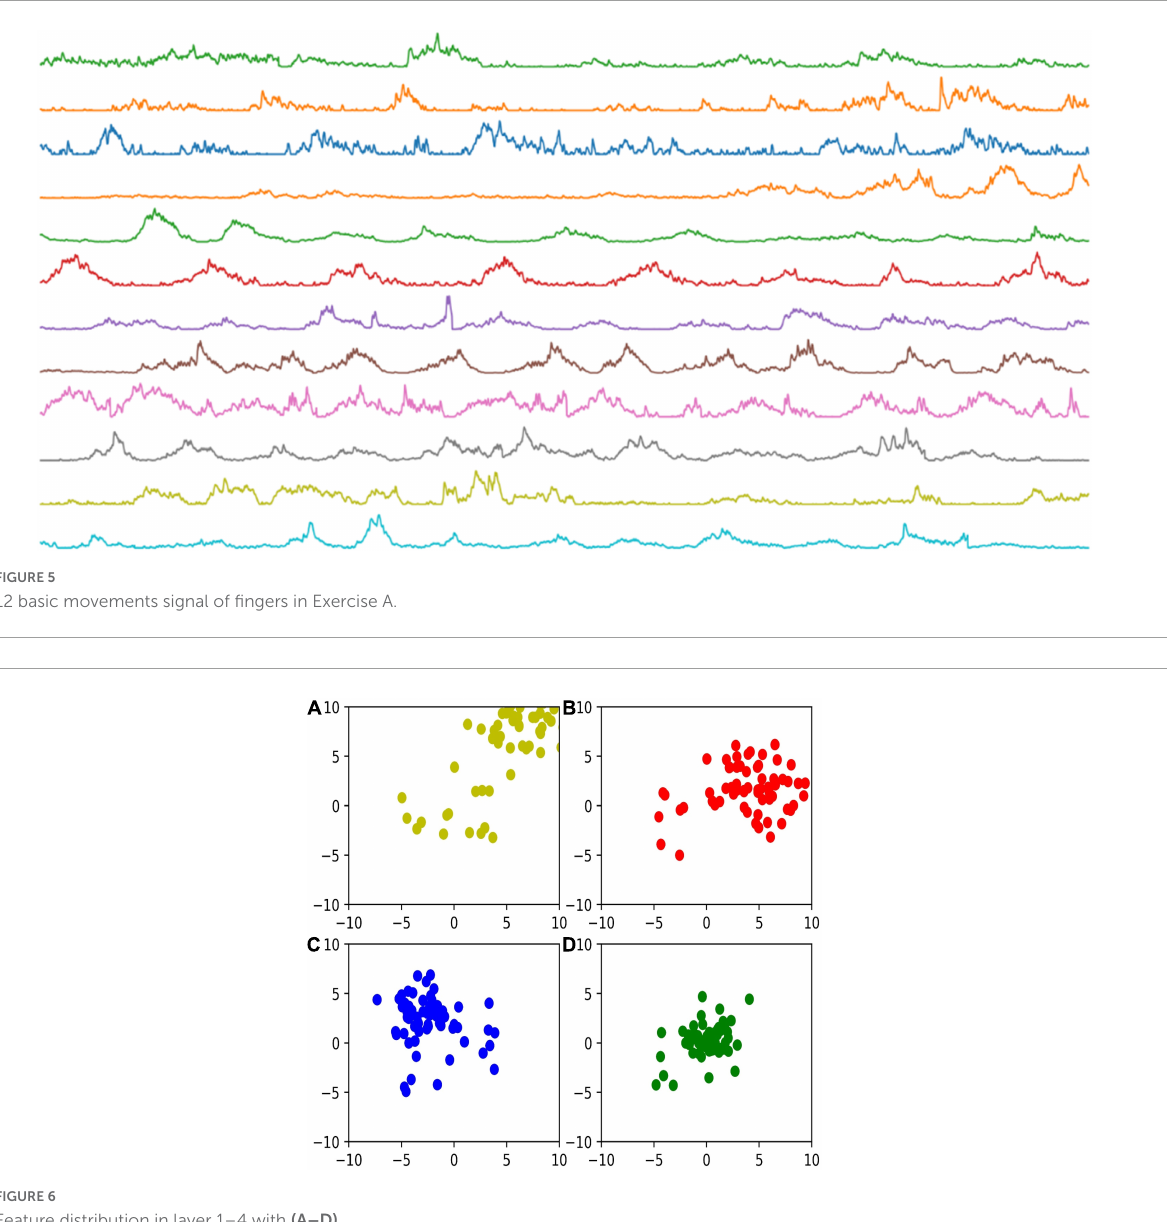
FIGURE6 Feature distribution in layer 1–4 with (A–D) .